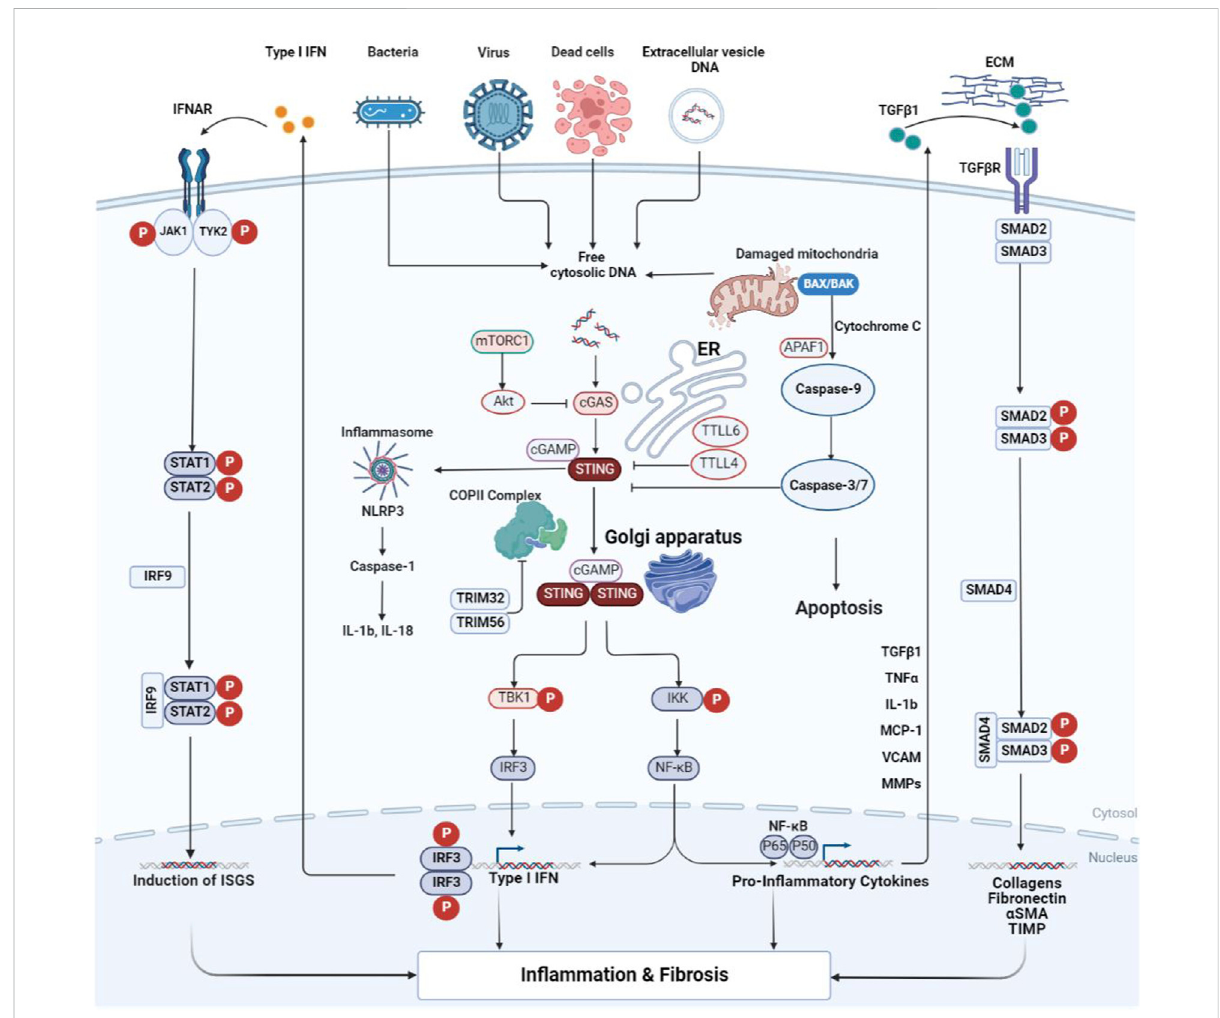
FIGURE 1 Crosstalk of the cGAS-STING signal transduction during in fl ammation and fi brosis. Cytoplasmic DNA from bacteria, viruses, dead cells, mitochondria, and extracellular vesicles is recognized by cGAS and thus activates STING. STING then exits the ER and transfers to the Golgi apparatus.Duringthisprocess, STINGcompletestherecruitmentofTBK1andIKK, aswellastheactivationofIRF3andNF- κ B.TGF- β activatesTGF- β receptors, resulting in phosphorylation of Smad2/3. The activated Smad2/3 enters the nucleus to promote transcription of fi brosis-related genes.Thepro-in fl ammatorycytokinesproducedbyNF- κ Bcanactonthesignaltransmission processofTGF- β /Smad.IFNfromtheSTINGpathway activates the IFN receptor, which is sequentially phosphorylated by the receptor-coupled JAK as well as downstream STAT, and the phosphorylated STAT dimer transfers to the nucleus to modulate gene transcription. cGAS is subject to negative regulatory effects induced by mTORC1 and Akt. It can also be inhibited in activity by TTLL4 and TTLL6, thus antagonizing the activation of STING. The apoptosis of the Bax pathway is initiated by caspase-9 and executed bycaspase3/7,thus inhibiting theeffect ofcGAS initiation. α -SMA, alpha smoothmuscleactin; Akt, proteinkinase B;APAF1, apoptotic protease activating factor-1; BAX, BCL2-associated X protein; cGAMP, cyclic GMP-AMP; cGAS, cyclic GMP-AMP synthase; COP II, coat proteincomplexII;ECM,extracellularmatrix;ER,endoplasmicreticulum;IFN,interferon;IFNAR,theinterferon- α / β receptor;IKK,inhibitorofkappaB kinase; IL, interleukin; IRF, interferon regulatory factor; ISGs, interferon-stimulated genes; JAK1, janus kinase 1; MCP-1, monocyte